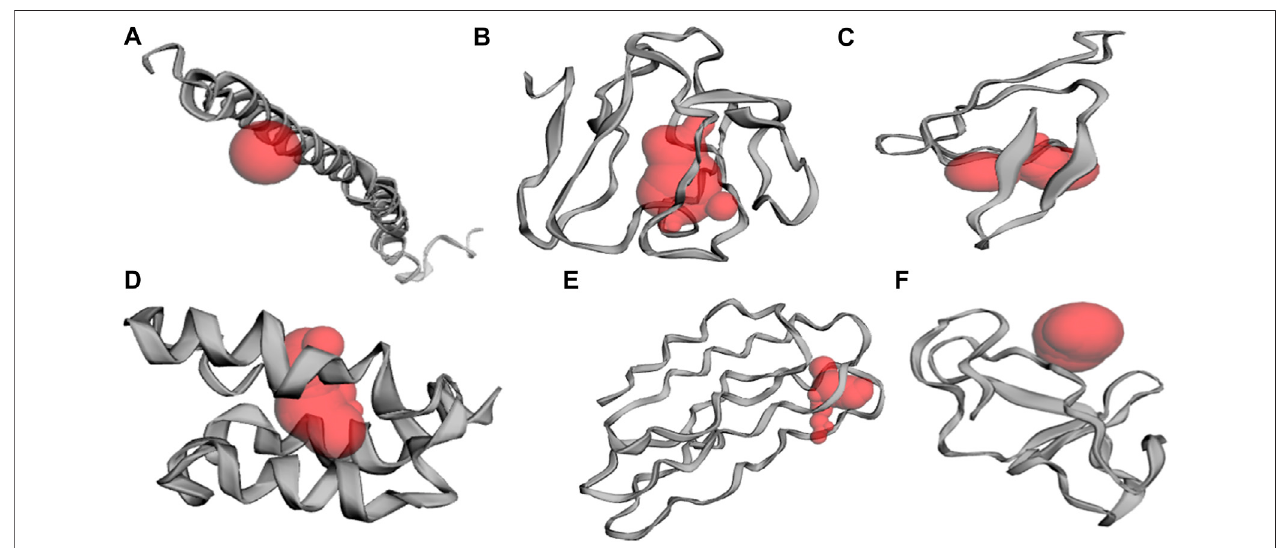
FIGURE 3 | Identi fi cation of active site pockets (highlighted in red cavity) for the shortlisted antigenic proteins (A) WP_104,732,835.1 (B) WP_009,906,007.1 (C) WP_003,429,932.1 (D) WP_021,396,478.1 (E) WP_021,389,778.1, and (F)